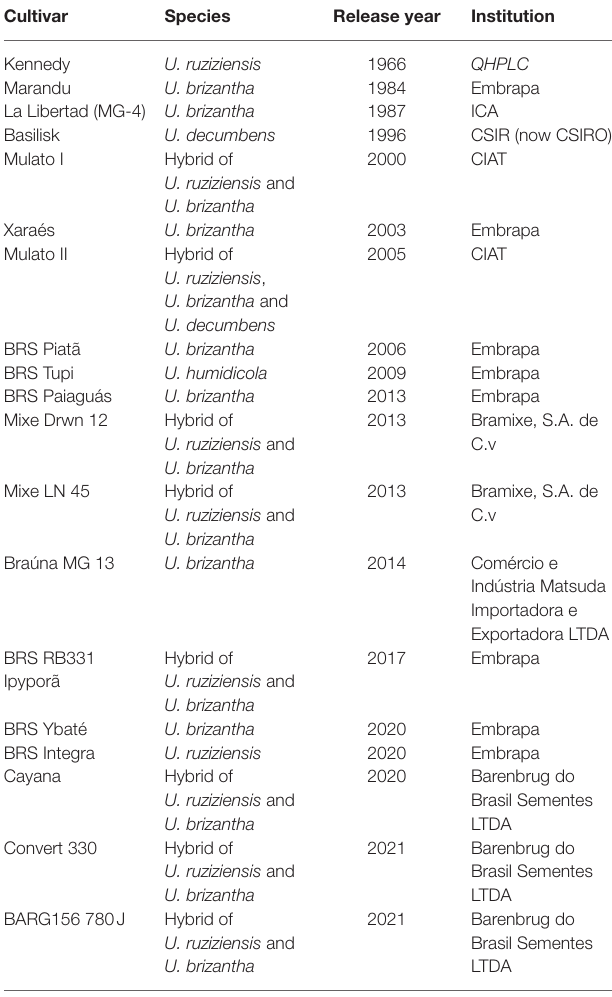
TABLE 1 | Commercially available Urochloa cultivars in the